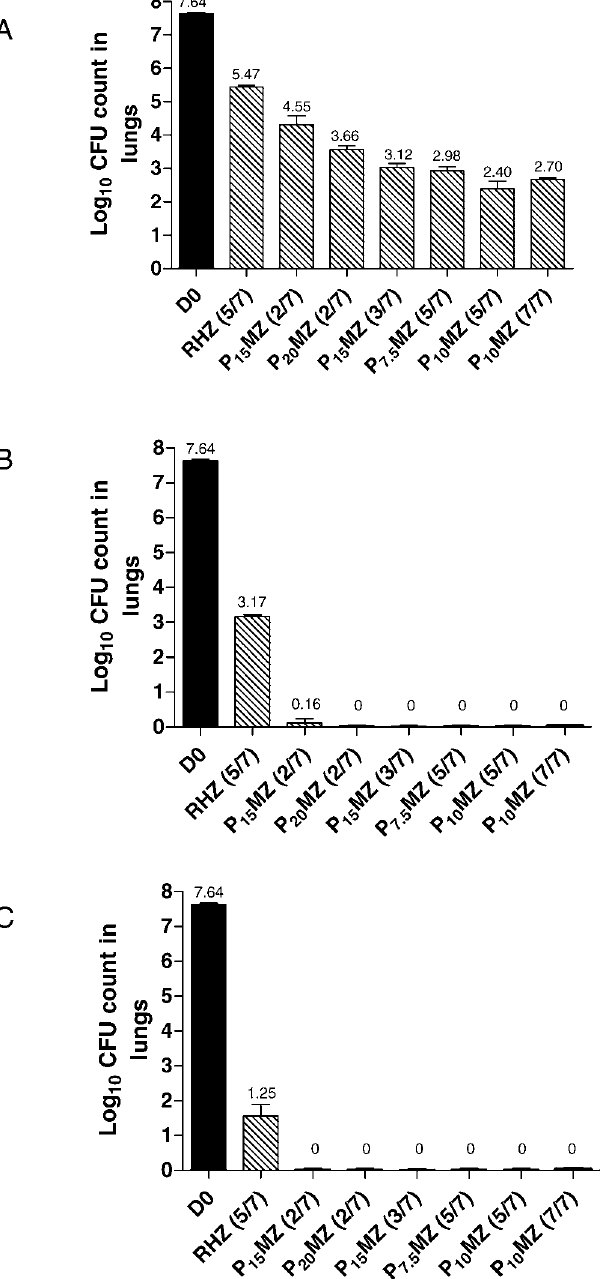
Figure 1. Lung Log 10 CFU Counts in M. tuberculosis –Infected Mice CFU counts at treatment initiation (D0) and (A) after 1 mo, (B) after 2 mo, and (C) after 3 mo of treatment. Data are presented as means and standard error (error bars) ( n ¼ five mice per time point). H, isoniazid; M, moxifloxacin; Z, pyrazinamide; R, rifampin; P, rifapentine.